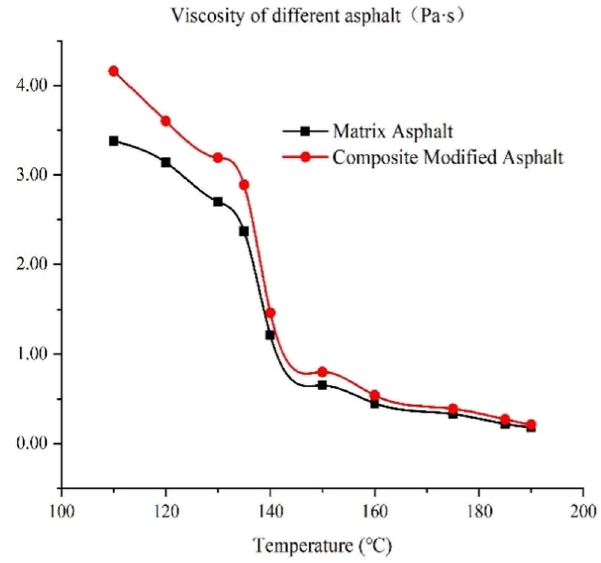
Figure 2: Results of Brook fi eld viscosity